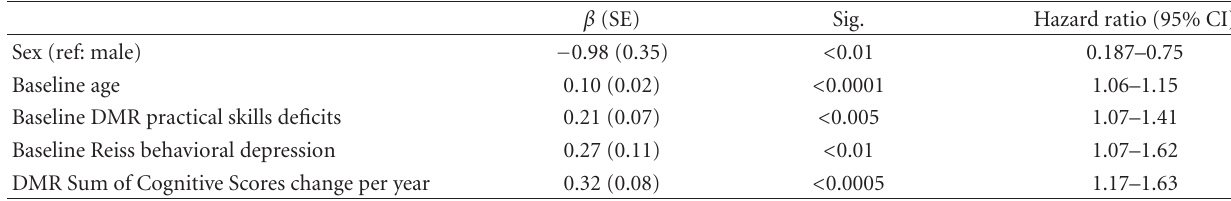
Table 7: Multivariate Cox regression analysis of mortality, as of July 2011 (DS).